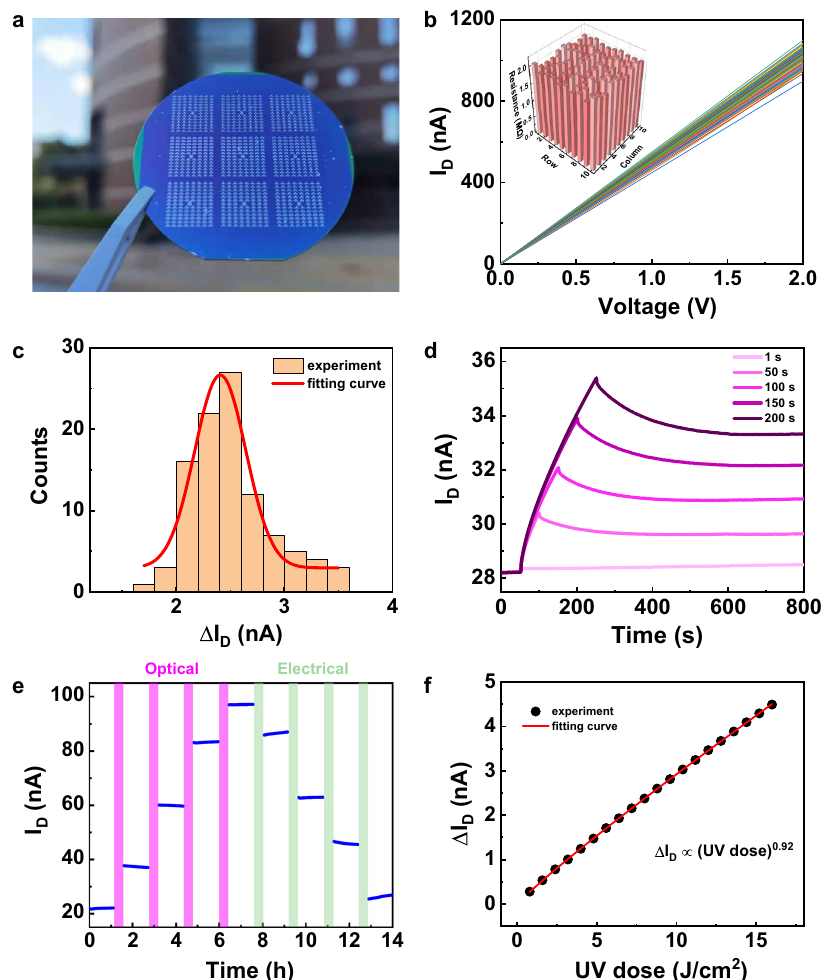
Fig. 4 Device performance for VO 2 fi lm on silicon wafer. a Photograph of the ch wafer. b I – V curves of 100 devices selected from the array. Inset: histogram of the devices ’ resistance. c Histogram of the photo response after 100 s of UV irradiation (84 mW/cm 2 ). The red line is the fi tting curve of a Gauss function. d spike-duration-dependent plasticity (intensity of 84 mW/cm 2 ) of a selected device. e Multi-state retention properties of VO 2 devices. The potentiation states were produced via UV irradiation, while the depression states via electrolyte gating. The regulation time was 0.5 h and the retention time was 4000 s. f Relationship between I D and incident UV dose with data extracted from Supplementary Fig. 15. The red line is the fi tting curve of a power function. A constant source-drain voltage V SD = 50 mV was applied to monitor the channel